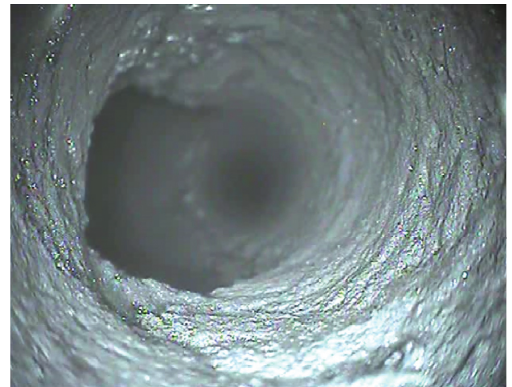
Figure 14: 2 # parallel drilling of coal side of test drilling.